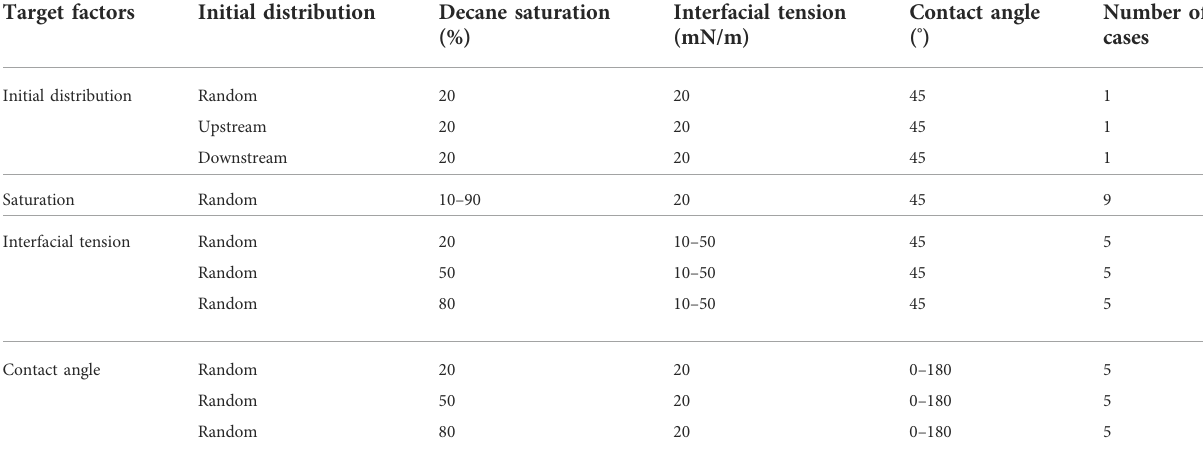
TABLE 2 The summary of parameters discussed in all simulation